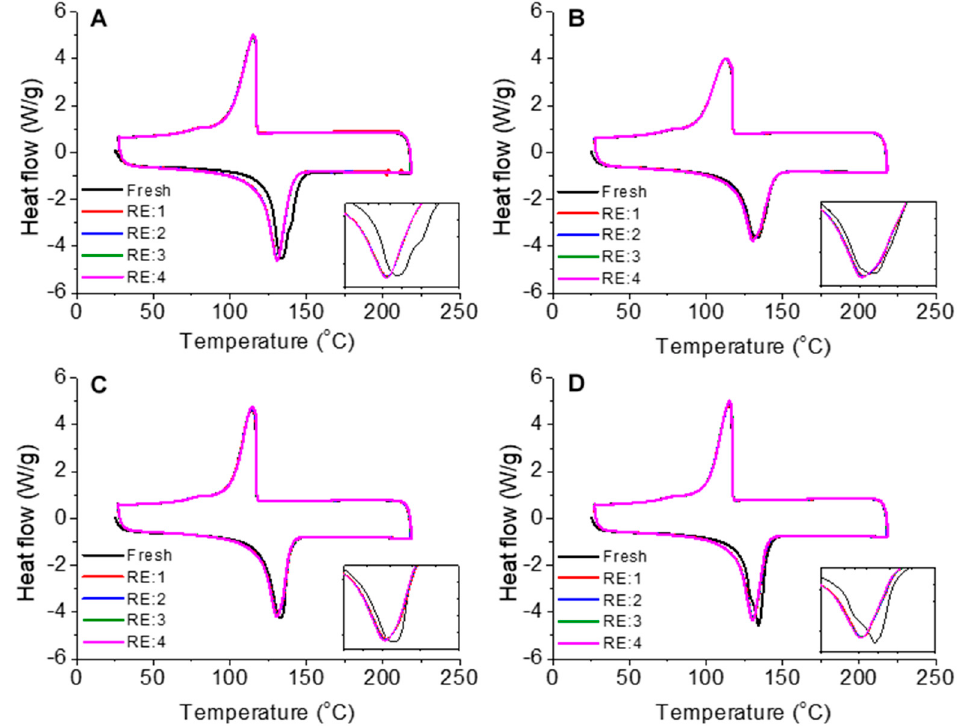
Figure 3. DSC thermograms (5 consecutive heating/cooling cycles): ( A ) Neat HDPE, ( B ) FA1/HDPE, ( C ) FA2/HDPE, and ( D ) FA3/HDPE. Table 1. DSC analysis results of the FA/HDPE composites.